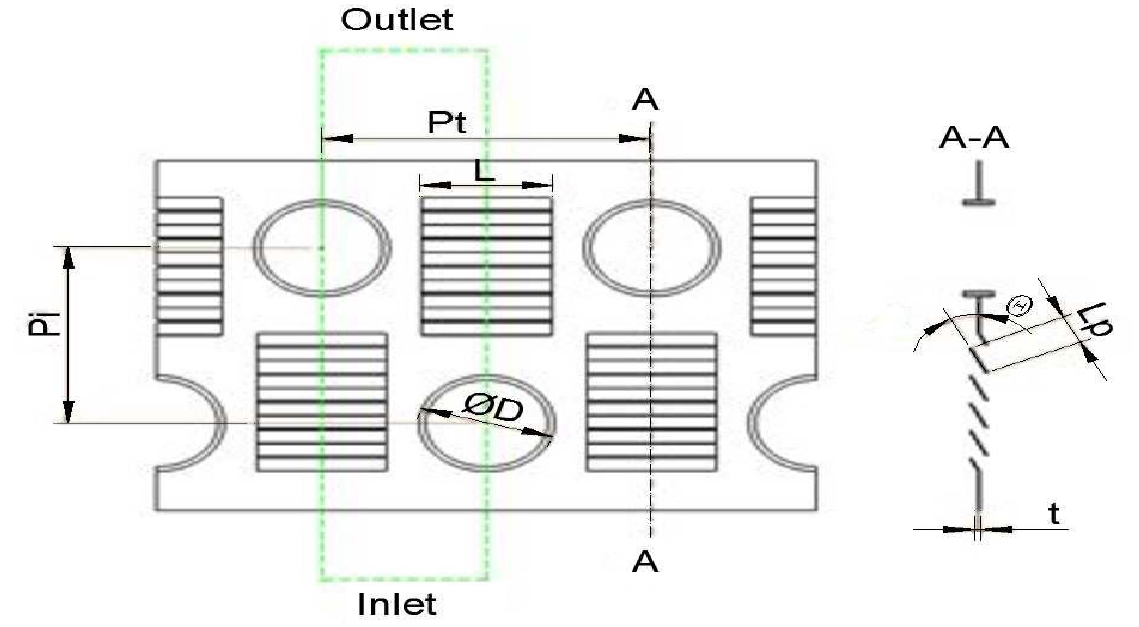
Figure 5: Plane and side visions of louvered fins and explanations of geometric parameters [6].